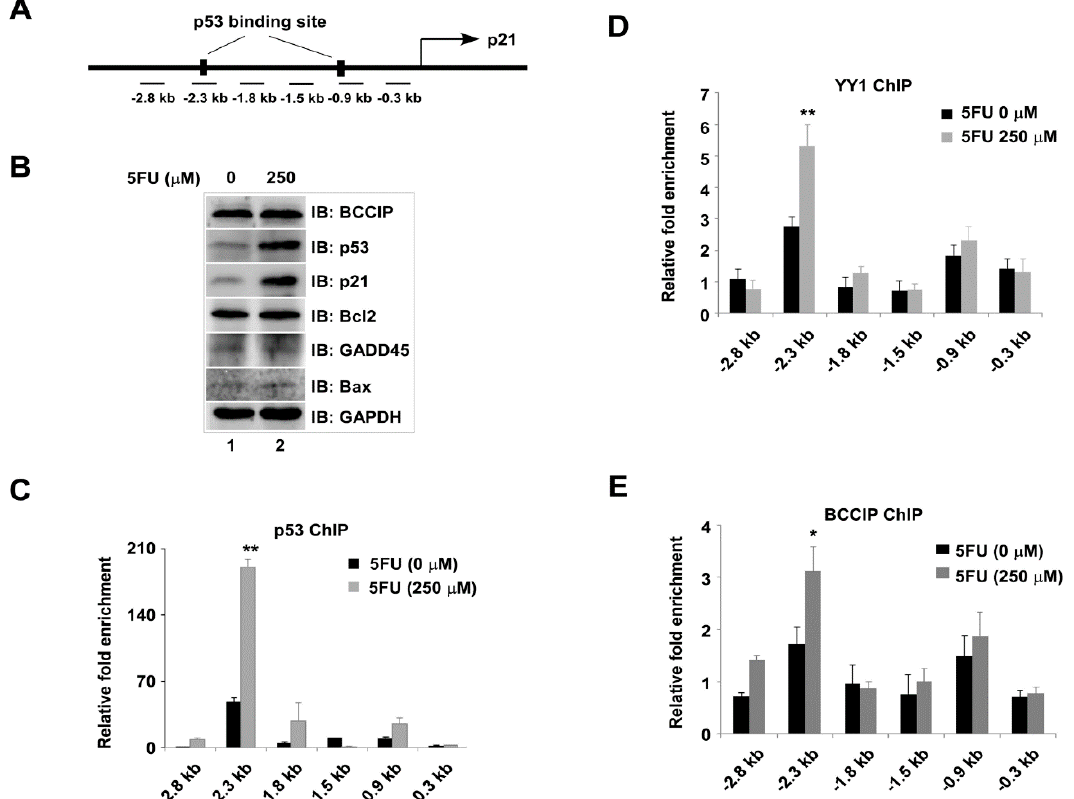
Figure 7. Co-occupancy of YY1, BCCIP, and p53 at p53RE sites in p21 gene in HCT116 cells. ( A ) Six primer sets at the p21 locus designed for amplifying chromatin immunoprecipitation (ChIP) DNA. Chromatin lysates were prepared from cells with or without 5FU treatment. 5FU-induced proteins were analyzed by western blot ( B ). ChIP experiments were performed using anti-p53 ( C ), anti-YY1 ( D ), and anti-BCCIP ( E ) antibodies. ChIP DNA amplified with qPCR. The y-axis shows the ratio of ChIP DNA signals to IgG, and all signals were normalized to input ( n = 3). * p < 0.05, ** p < 0.01, t -test, comparison to 5FU untreated